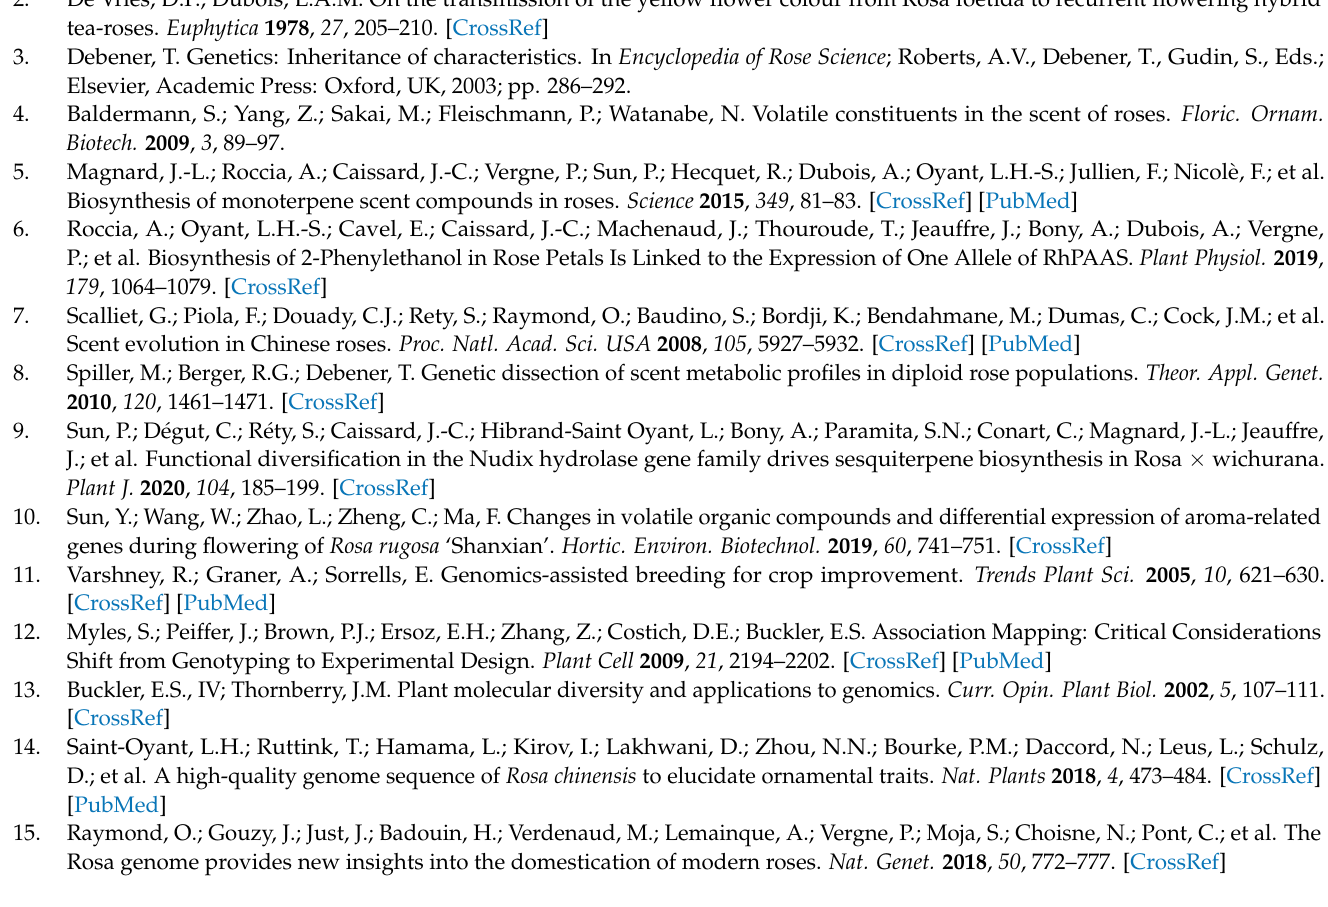
cultivars. Table S7: Distribution of allele dosage of KASP marker Rh_FR_SNP201K for fragrance in the association panel of 95 cultivars. Table S8: Validation of KASP marker Rh_FR_SNP201K with 282 independent rose cultivars. Table S9: Significant SNPs associated with petal number in roses. Table S10: Significant SNPs associated with petal length in roses. Table S11: Significant SNPs associated with fragrance in